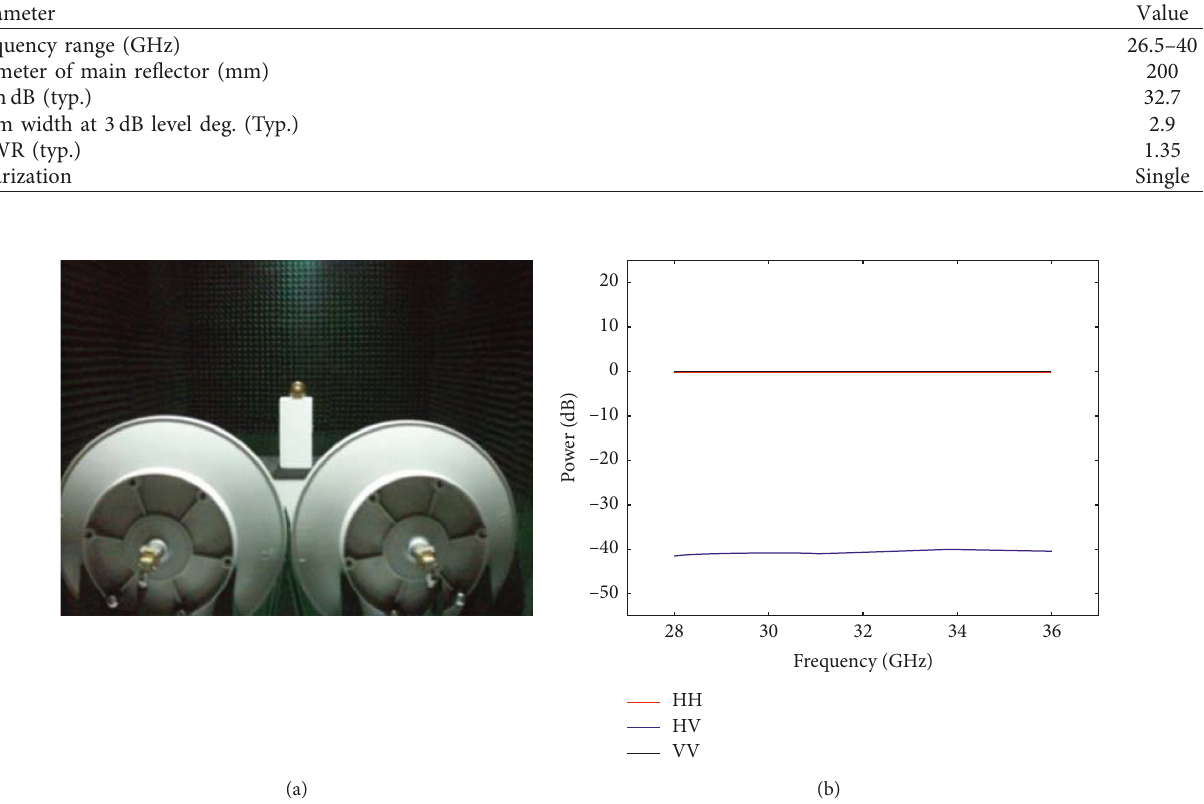
Figure 4: (a) Measurement scene; (b) returned signal at HH, HV, and VV polarizations after polarimetric calibration.